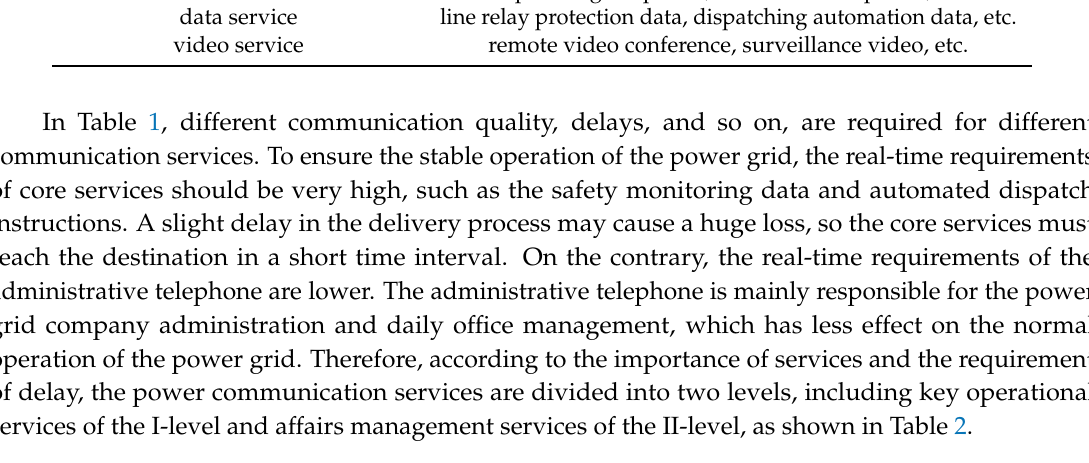
Table 2. Classification of power communication